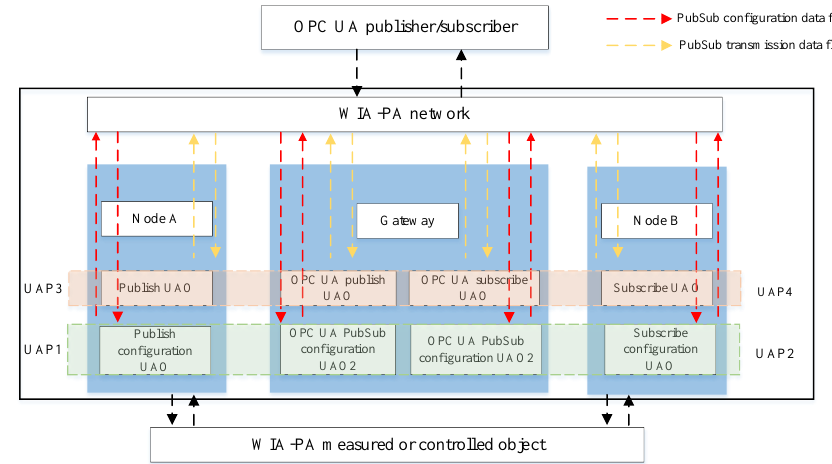
Figure 9. WIA-PA/OPC UA joint communication mechanism.